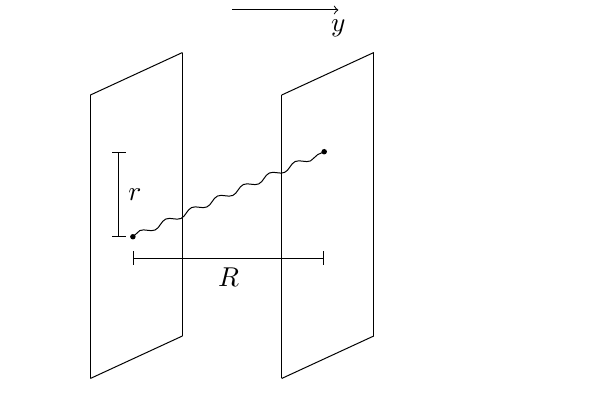
Figure 1. Potential energy between two static point sources on di(cid:11)erent, parallel branes, mediated by the scalar